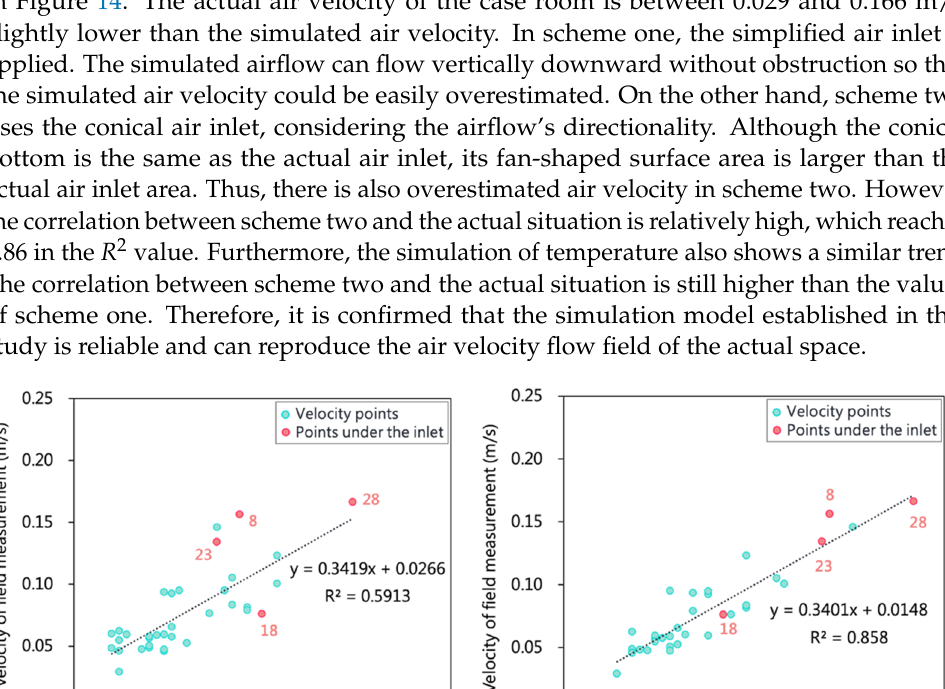
Figure 12. Temperature distribution measurement results: plan and profile of the case room.